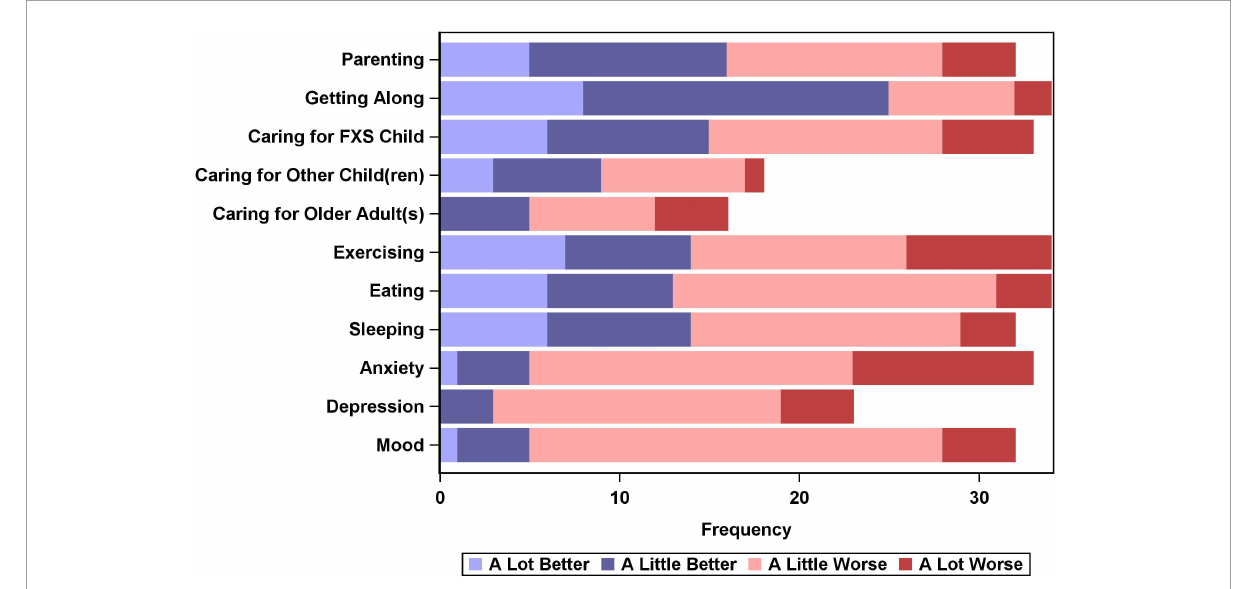
FIGURE1 Distribution of CEFIS-impact scale item responses.